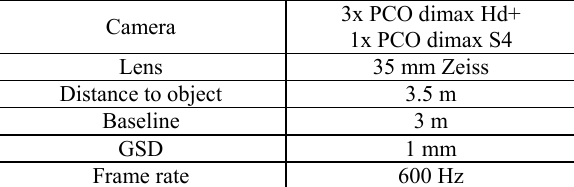
Figure 2 . Influence of different bandwidths on probability density function.